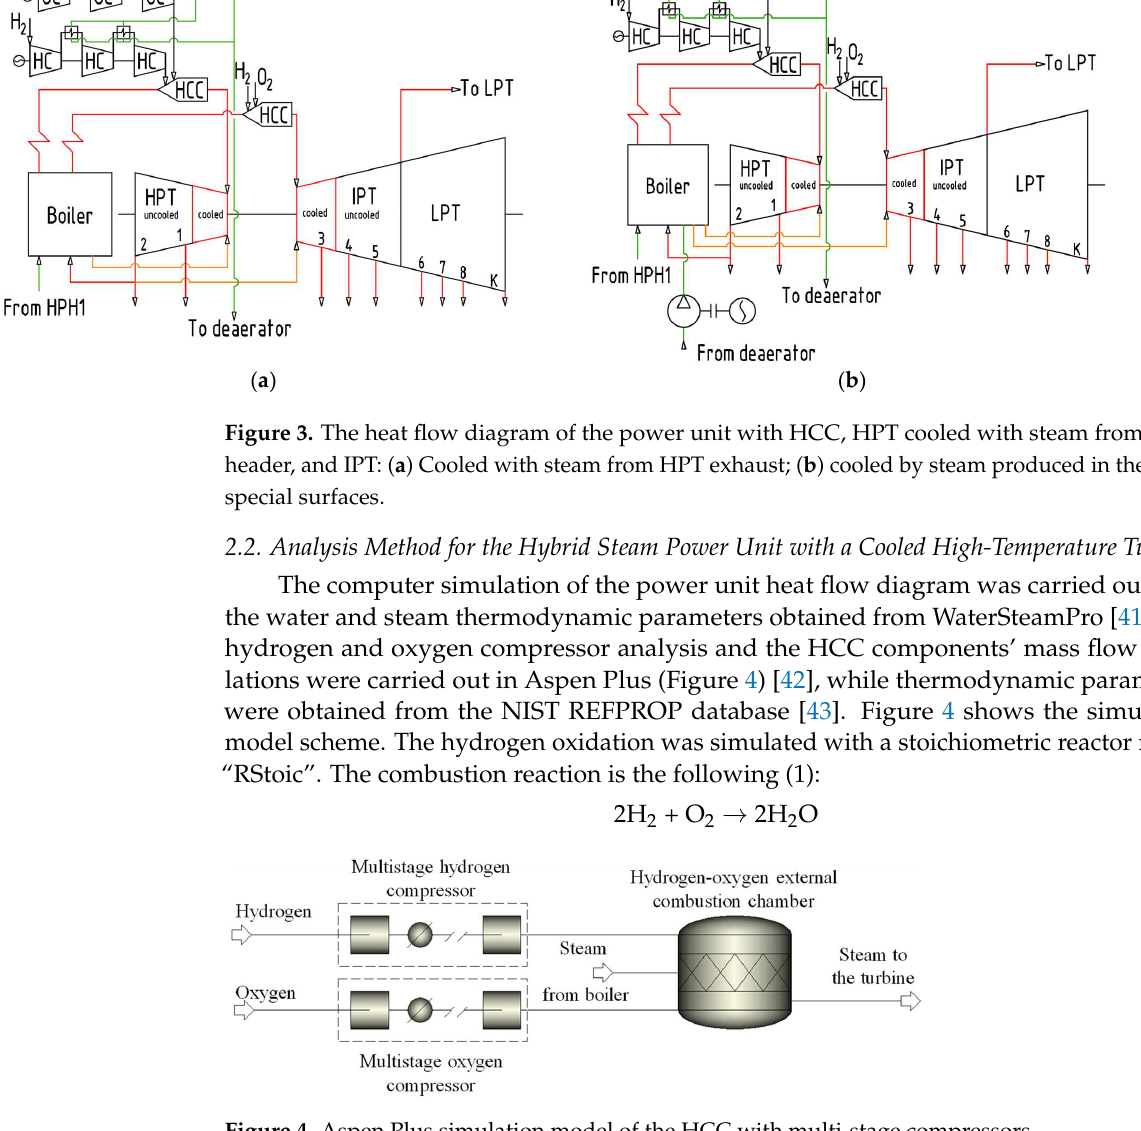
Table 4. Input data for the multi-stage compressor